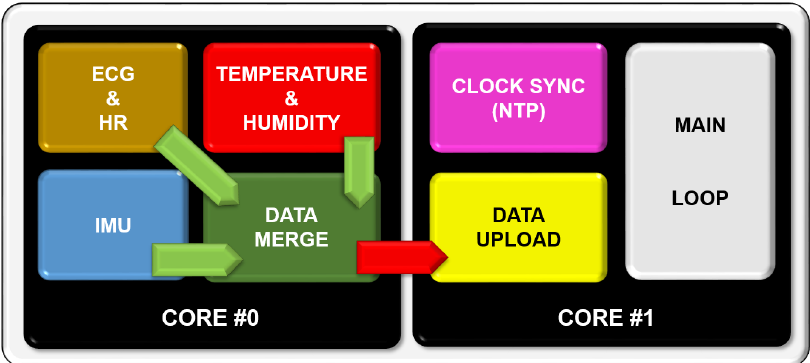
Figure 5. Task definition and message queues. One core is used for data acquisition and processing while the other one is left for communication